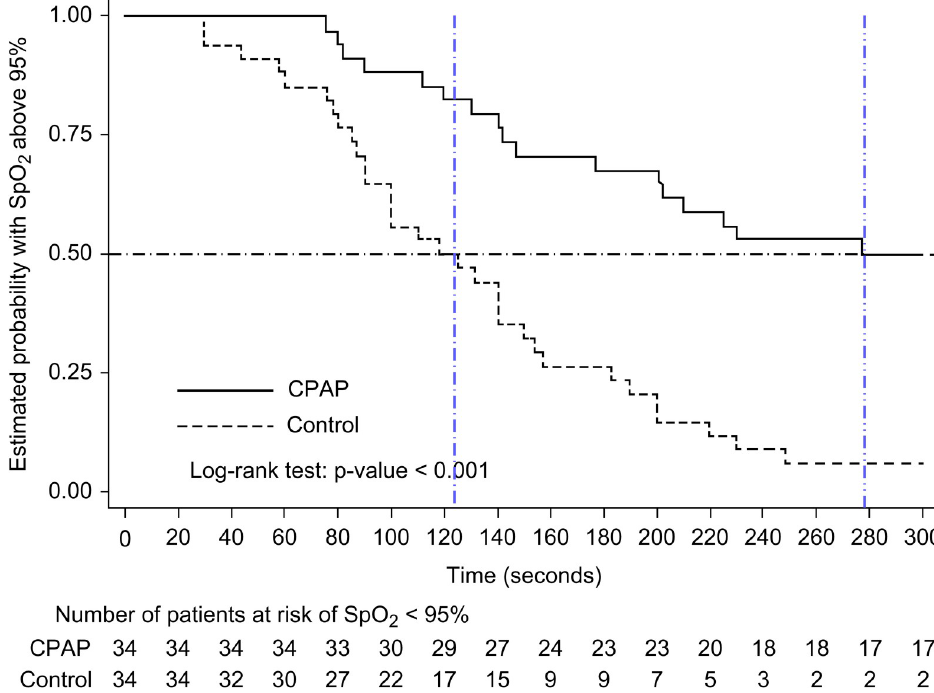
Fig 2. Kaplan–Meier curves for the CPAP and control groups. Occurrence of an SpO 2 of 95% during a 5-min follow-up in children with CPAP ventilation and passive CPAP oxygenation (10 cmH 2 O) or no positive airway pressure (0 cmH 2 O) during anaesthesia induction for elective surgery showing a significant difference between the survival curves (log-rank test; p < 0.001).